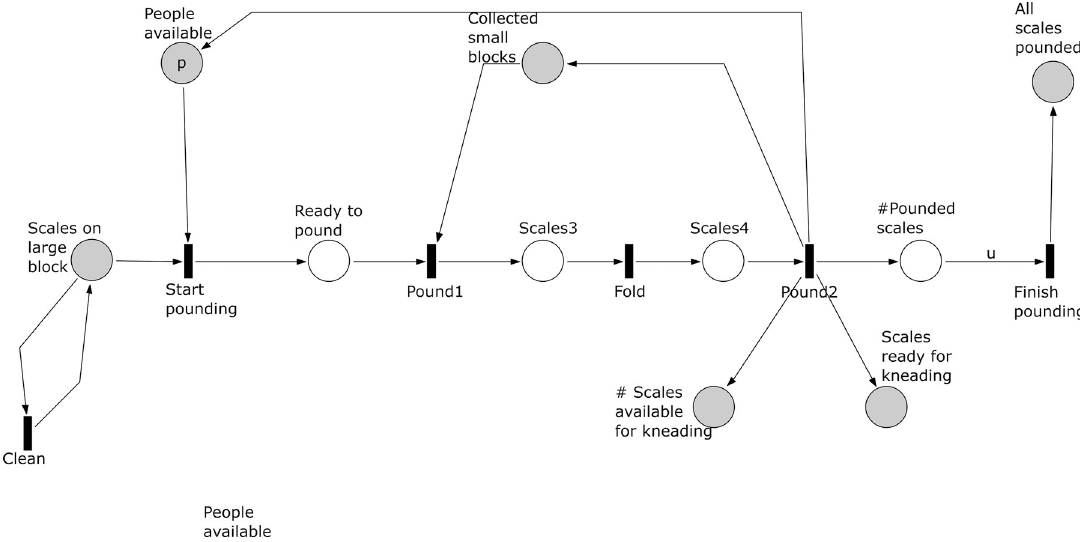
Fig 9. Subprocess 7 Pound of the A . coranica